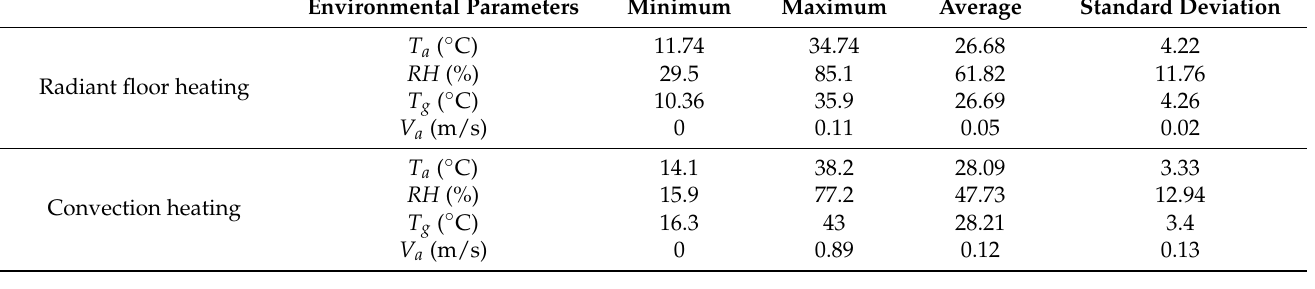
Table 6. Descriptive statistics on the parameters affecting the interior environment.